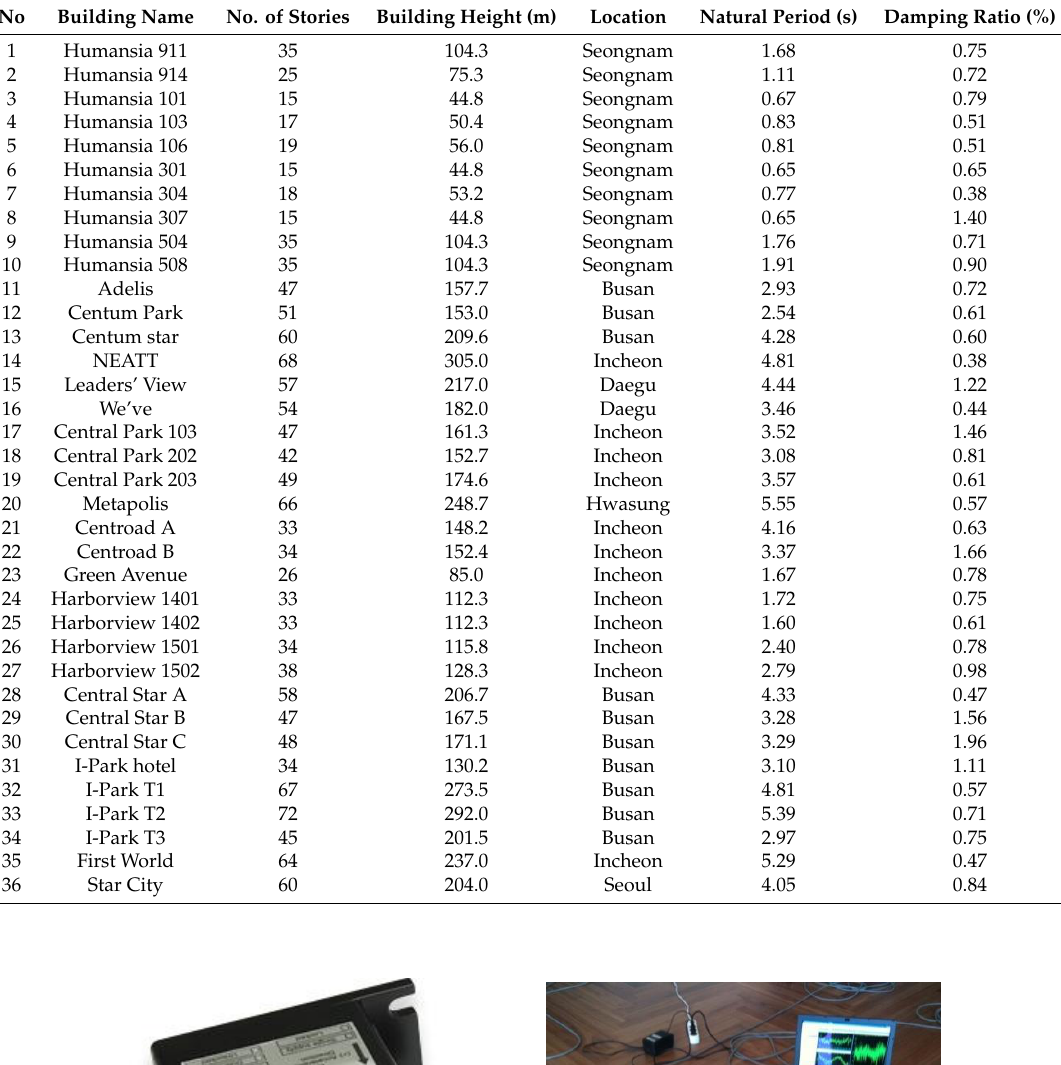
Table 7. List of RC buildings for ambient vibration measurement.